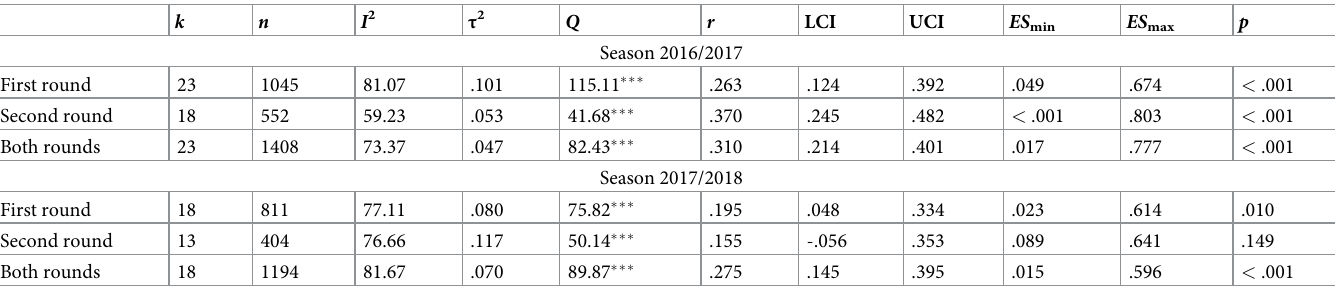
Table 4. Associations of gate points with round